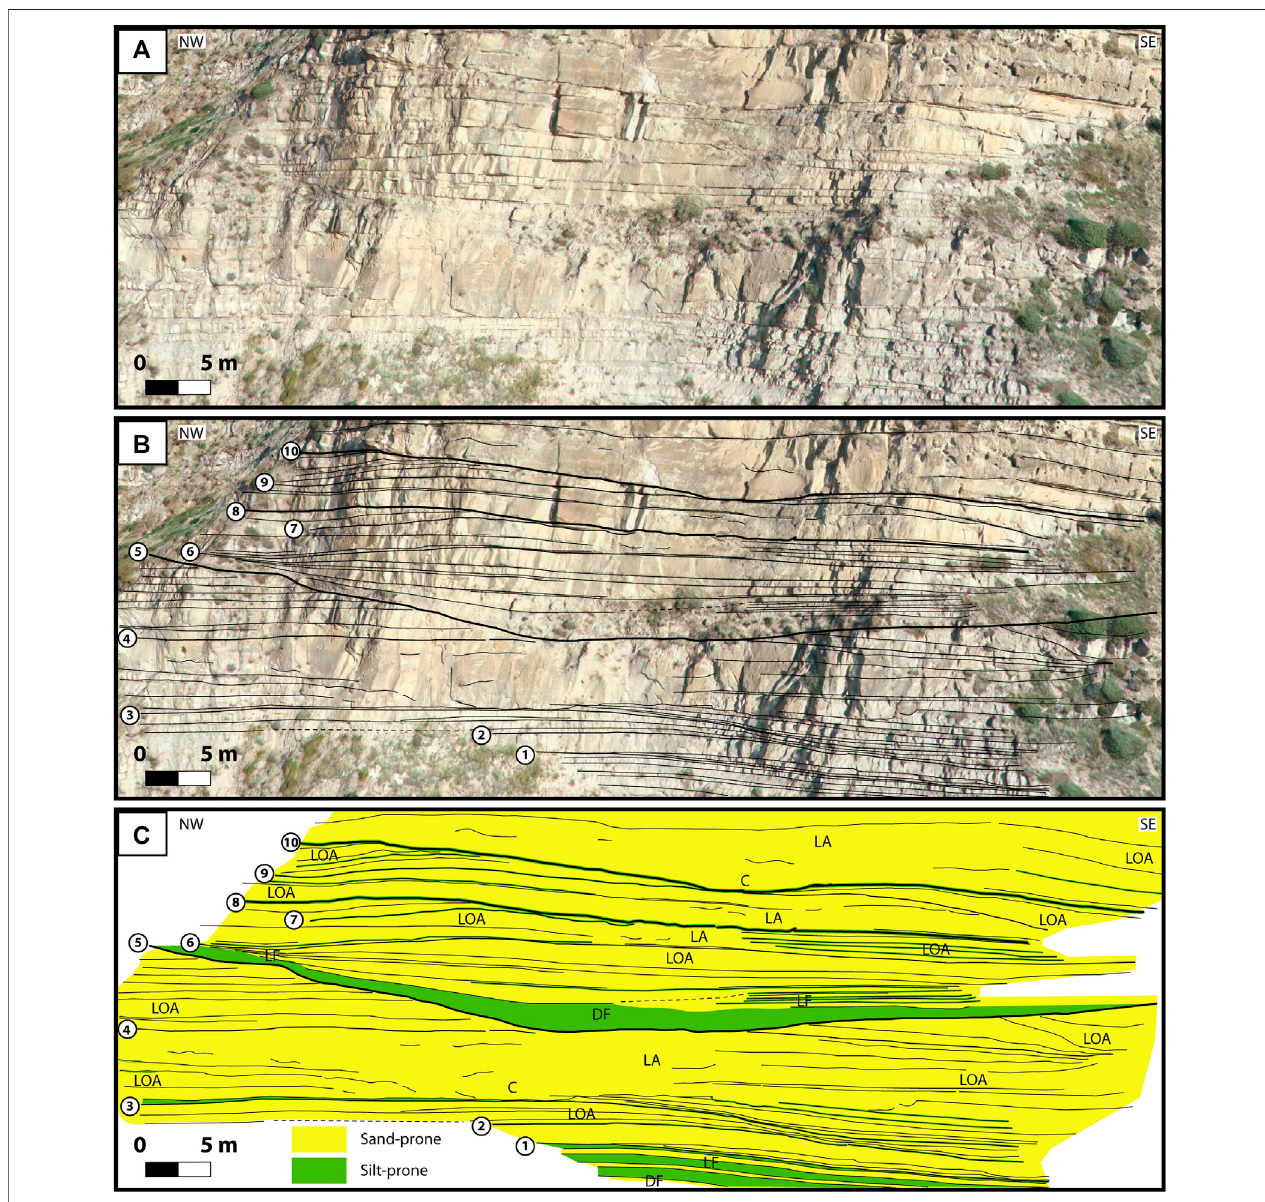
FIGURE 8 | Stratigraphic architecture of the Motta area illustrating Channel-Lobe transition zone. Panoramic view extracted from the 3D outcrop model (A) and interpretation (B,C) . The main surfaces discussed in the text (1 – 10) are highlighted. Surfaces at the top of lobe are represented by thicker dark lines (Lines 5, 8, and 10). Lobes are composed of several lobe elements. (C) Channel, (Le) Levee, (LA) Lobe axis, (LOA) Lobe off-axis, (LF) Lobe fringe, (DF) Distal lobe fringe. See text for further explanations.